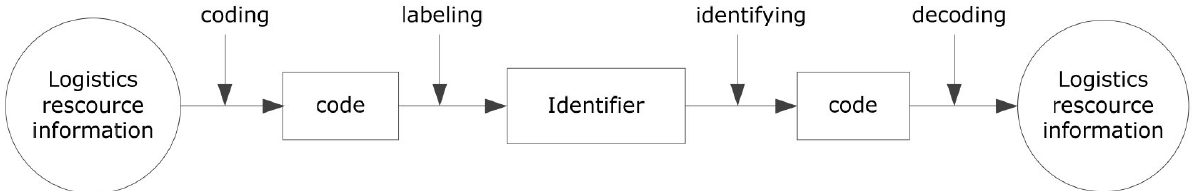
Figure 1. Object Identifier Operation Conceptual Model (Zhang,